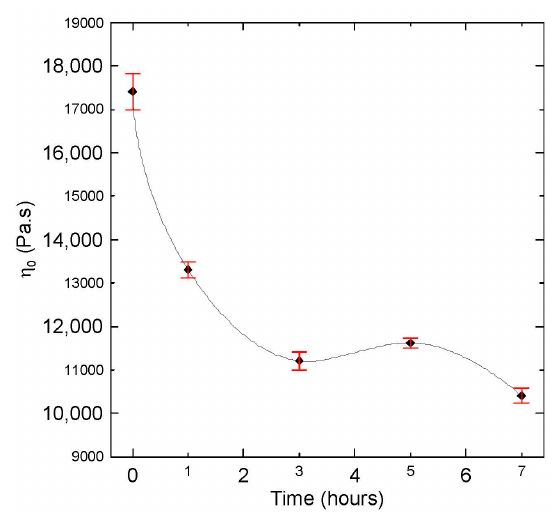
Figure 4. Newtonian viscosity, η 0 , for virgin and degraded polypropylenes obtained from shear creep measurements at 180 °C.